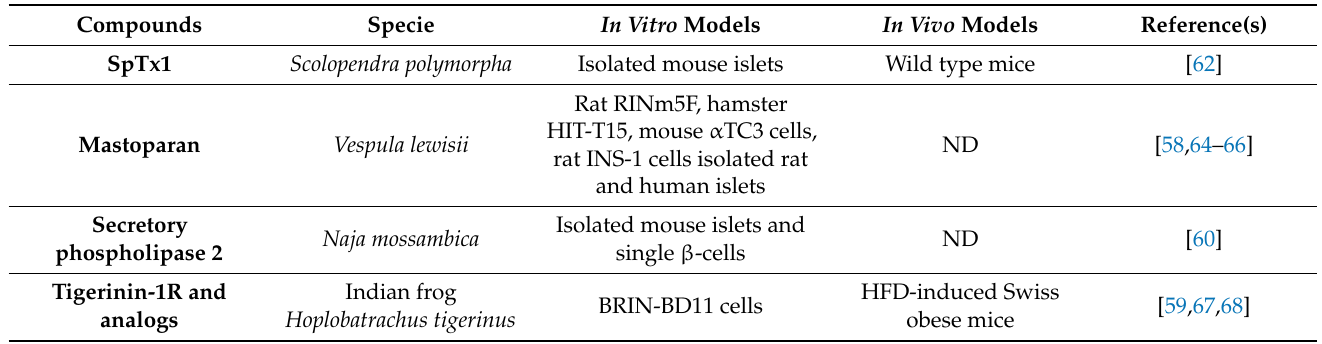
Table 1. K + ATP inhibitor peptides that stimulate insulin